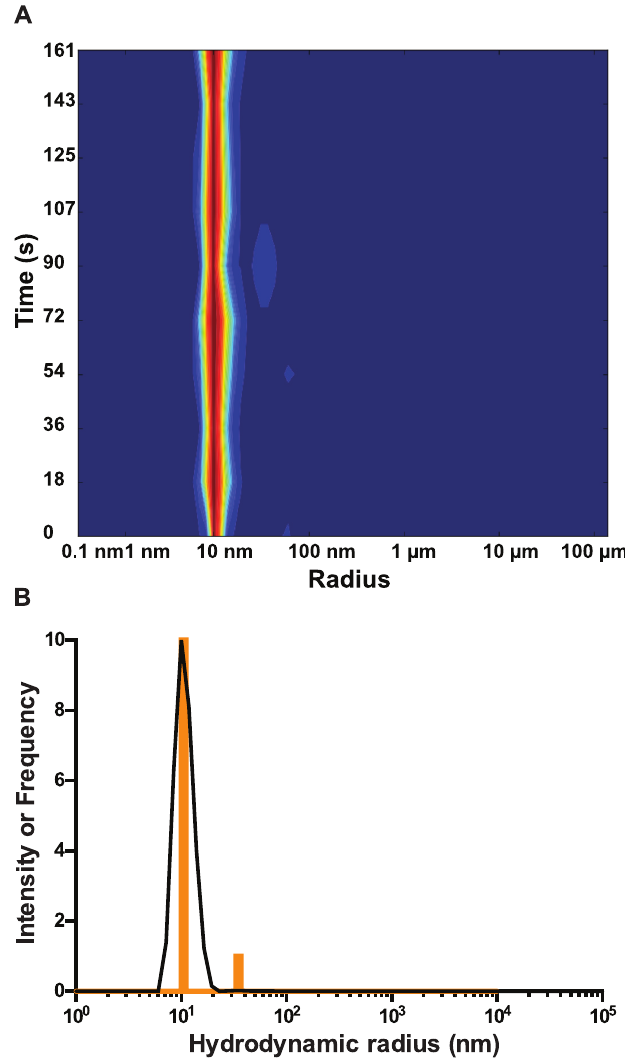
Fig 9. Dynamic light scattering measurements show that PelB-Vpu is monodispersed. The complexof detergentand PelB-Vpu was detected as a narrowpeak at 10 nm . A molecularweight of 332.2 kDa was predicted for the protein-detergent complex . Monodispersity of PelB-Vpu(10 mg/mL) is shown by the heat map diagram (A) and a plot of frequency of each particle size estimated from multiplemeasurements